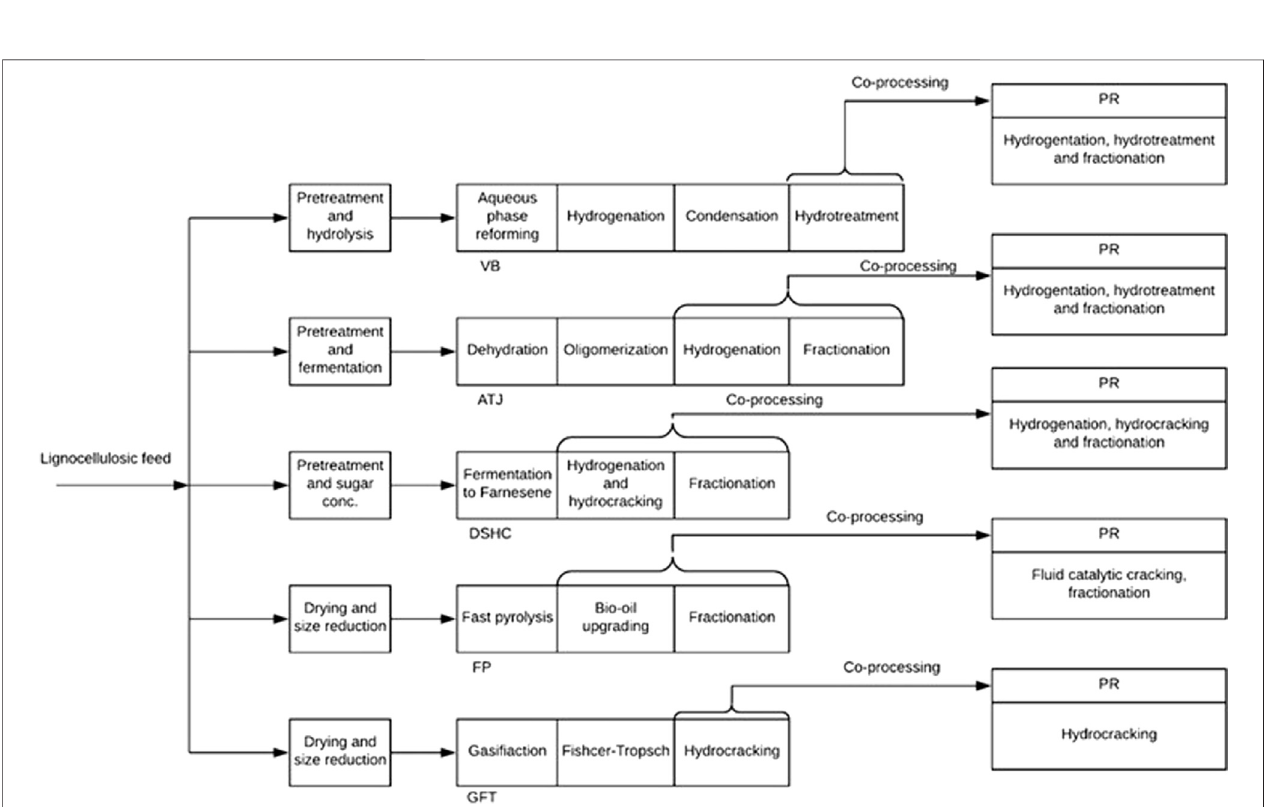
FIGURE 1 | Schematic of the proposed co-processing scenarios between an existing PR and emerging SAF processes.